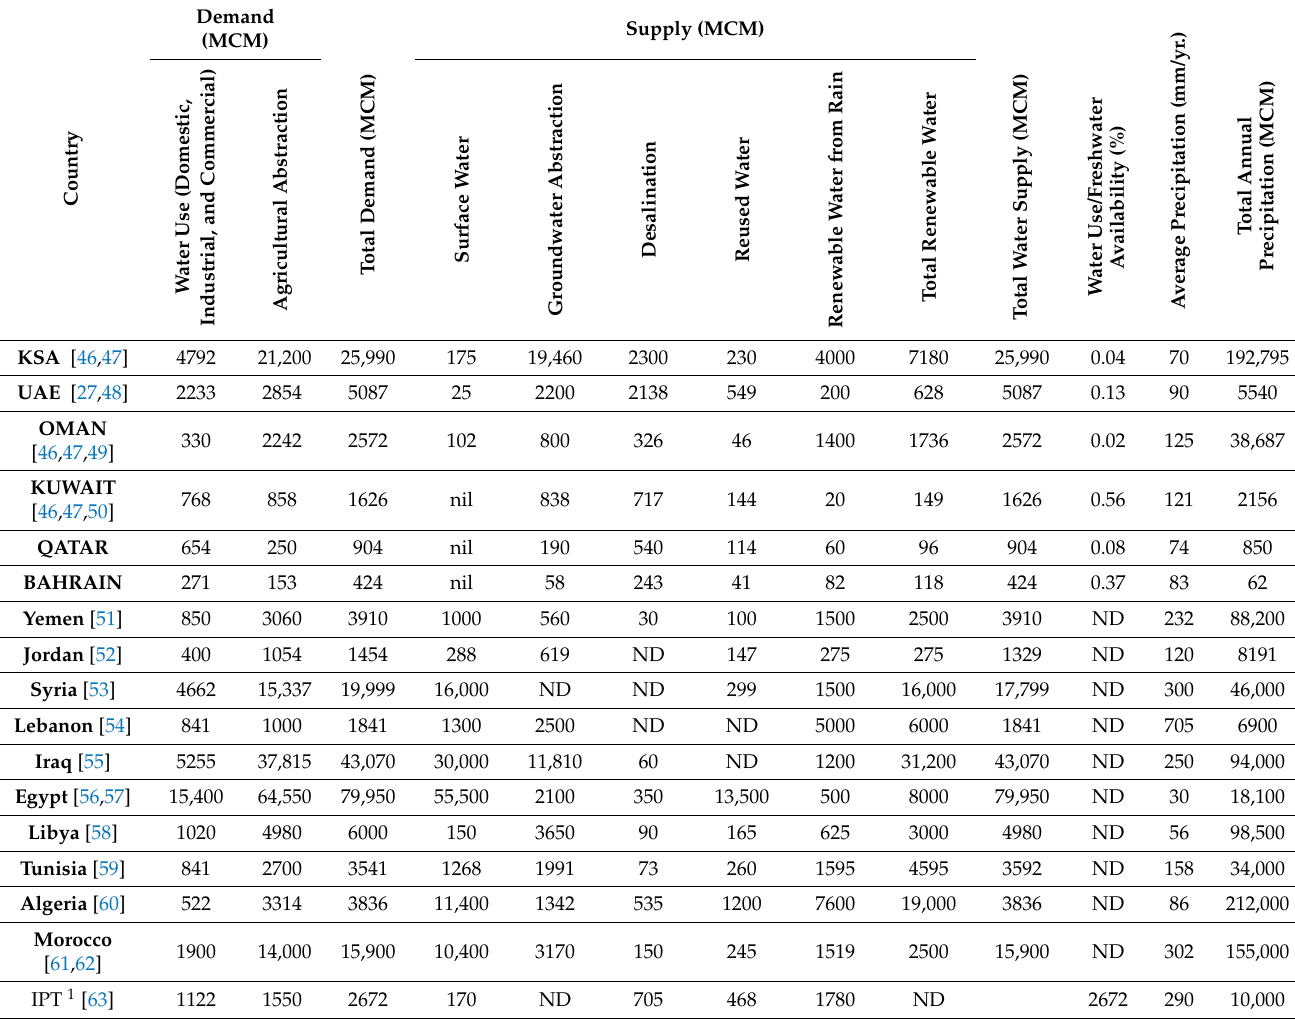
Table 1. Water balance in MENA region countries and calculated water use/freshwater availability